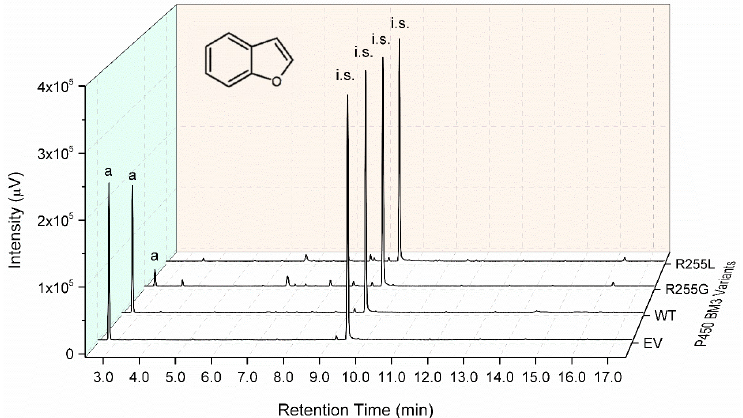
Figure A14. Product analysis via GC-FID after conversion of benzofuran with lysate from EV (negative control), P450 BM3 WT, and from variants R255G and R255L. The data was obtained from